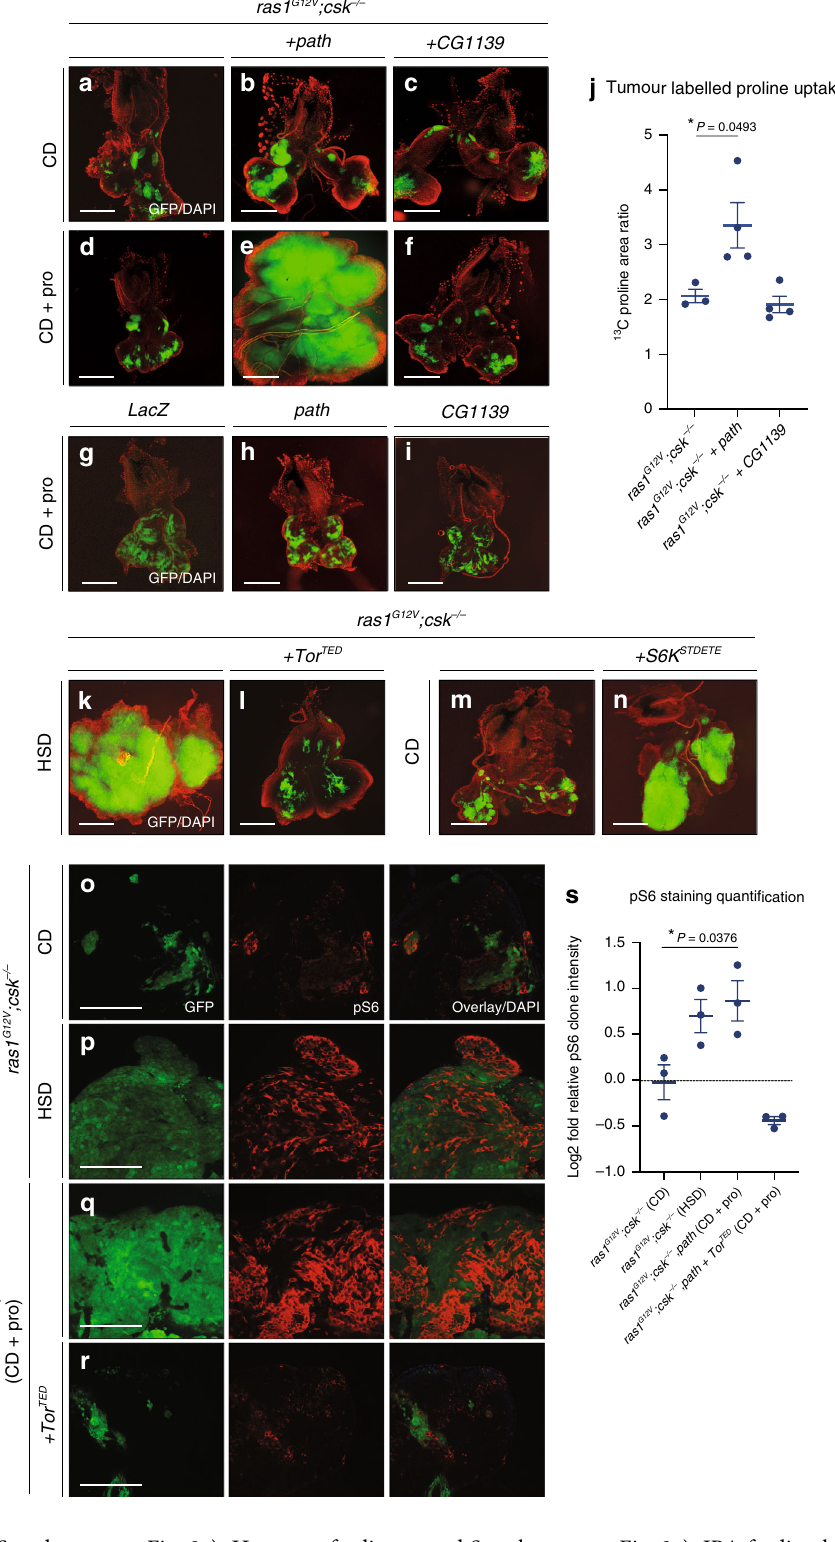
and Supplementary Fig. 8g). IPA feeding had no effect on benign tumour growth in ras1 G12V ; csk − / − animals raised on CD (Fig. 6e, f and Supplementary Fig. 8h) supporting the notion that SLC36 inhibition only limits the growth of tumours with proline vul- nerability. Furthermore, IPA suppressed ras1 G12V ; csk − / − ,path - tumour growth in proline-fed animals in CD, and increasing the dietary concentrations of proline partially out-competed